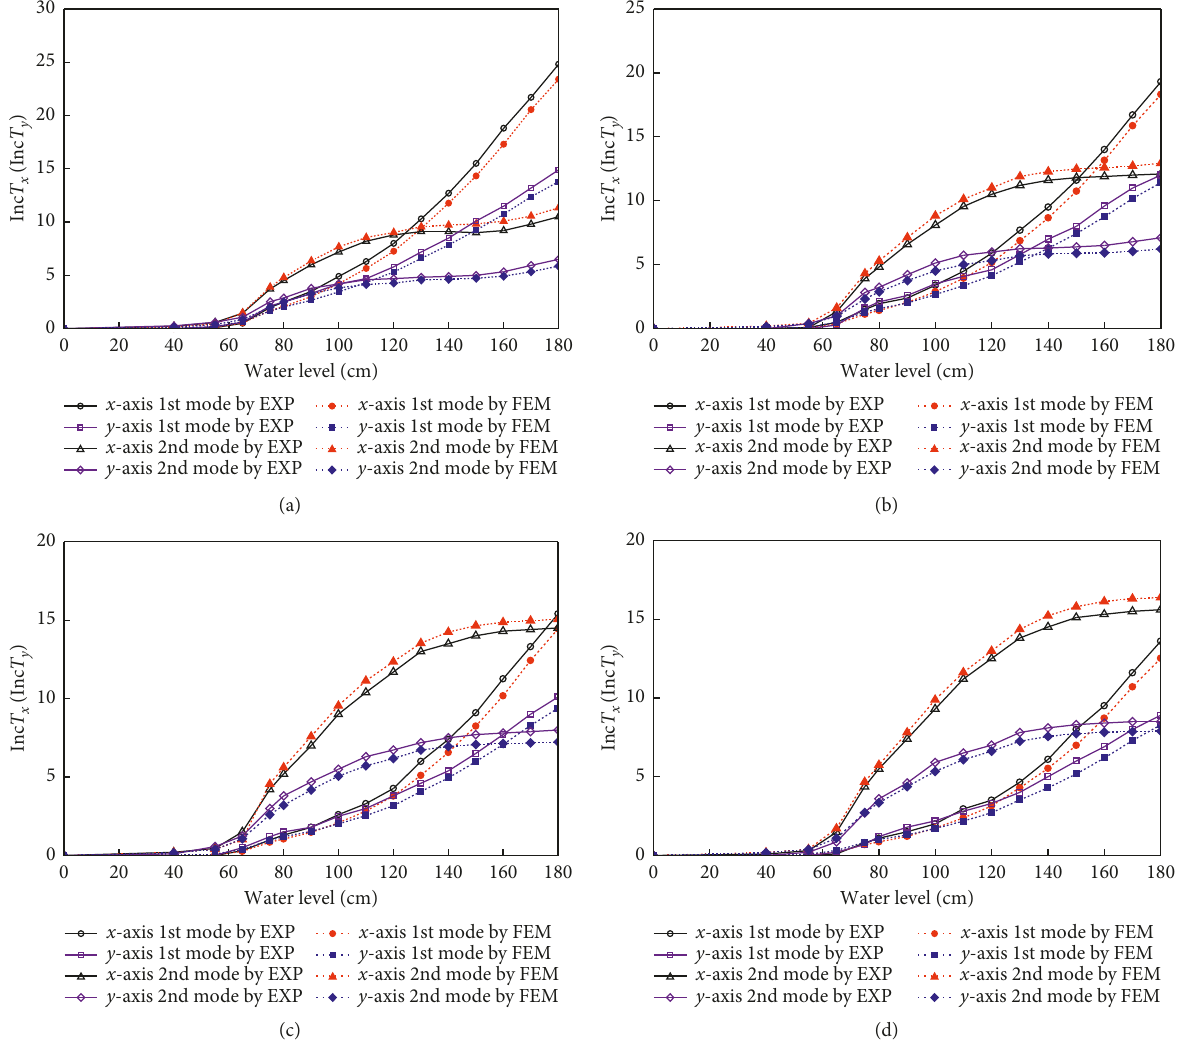
Figure 6: Measured and computed percentage increases of vibration period for the hollow pier specimen in case I as a function of water level: (a) without tip mass; (b) with an 11.4kg tip mass; (c) with a 23.4kg tip mass; and (d) with a 31.7kg tip